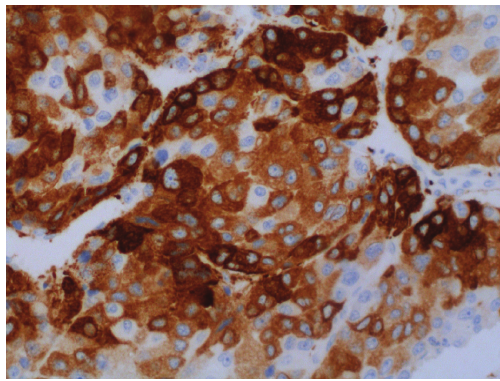
Figure 2: Inhibin expression (immunohistochemistry); origin marker in adrenal cortex.